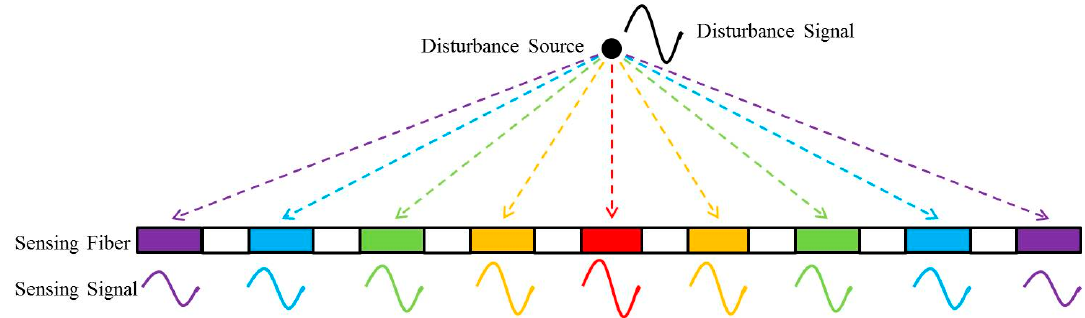
Figure 12. Perceptual model on length axis.